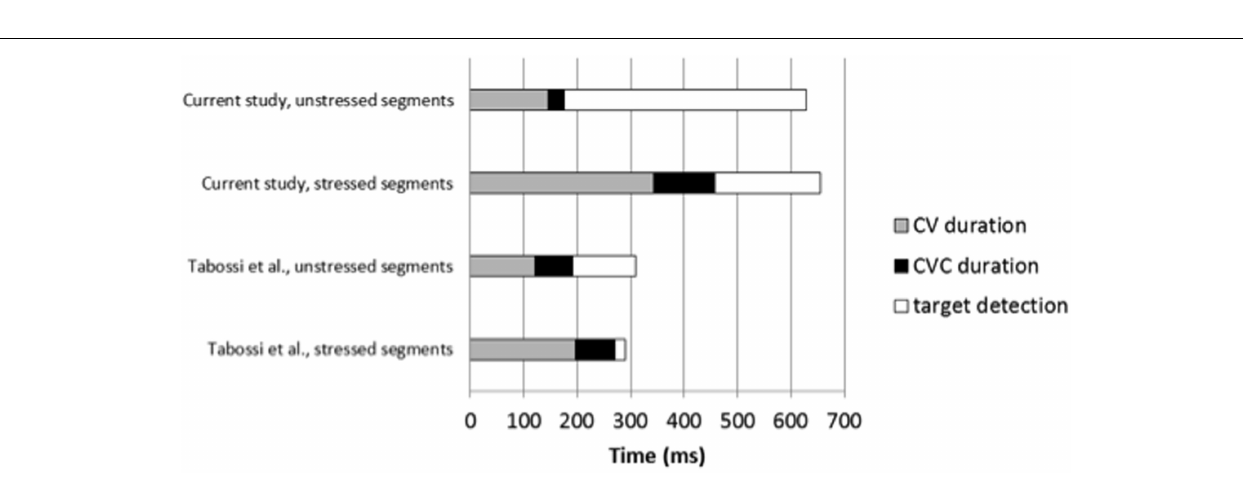
FIGURE 3 |Analysis of the time course of events in theTabossi et al. (2000) second experiment (two bars below) and in Experiment 1 of the current study (two bars above): gray bars correspond to the mean duration of CV portions in unstressed and stressed carriers, black bars